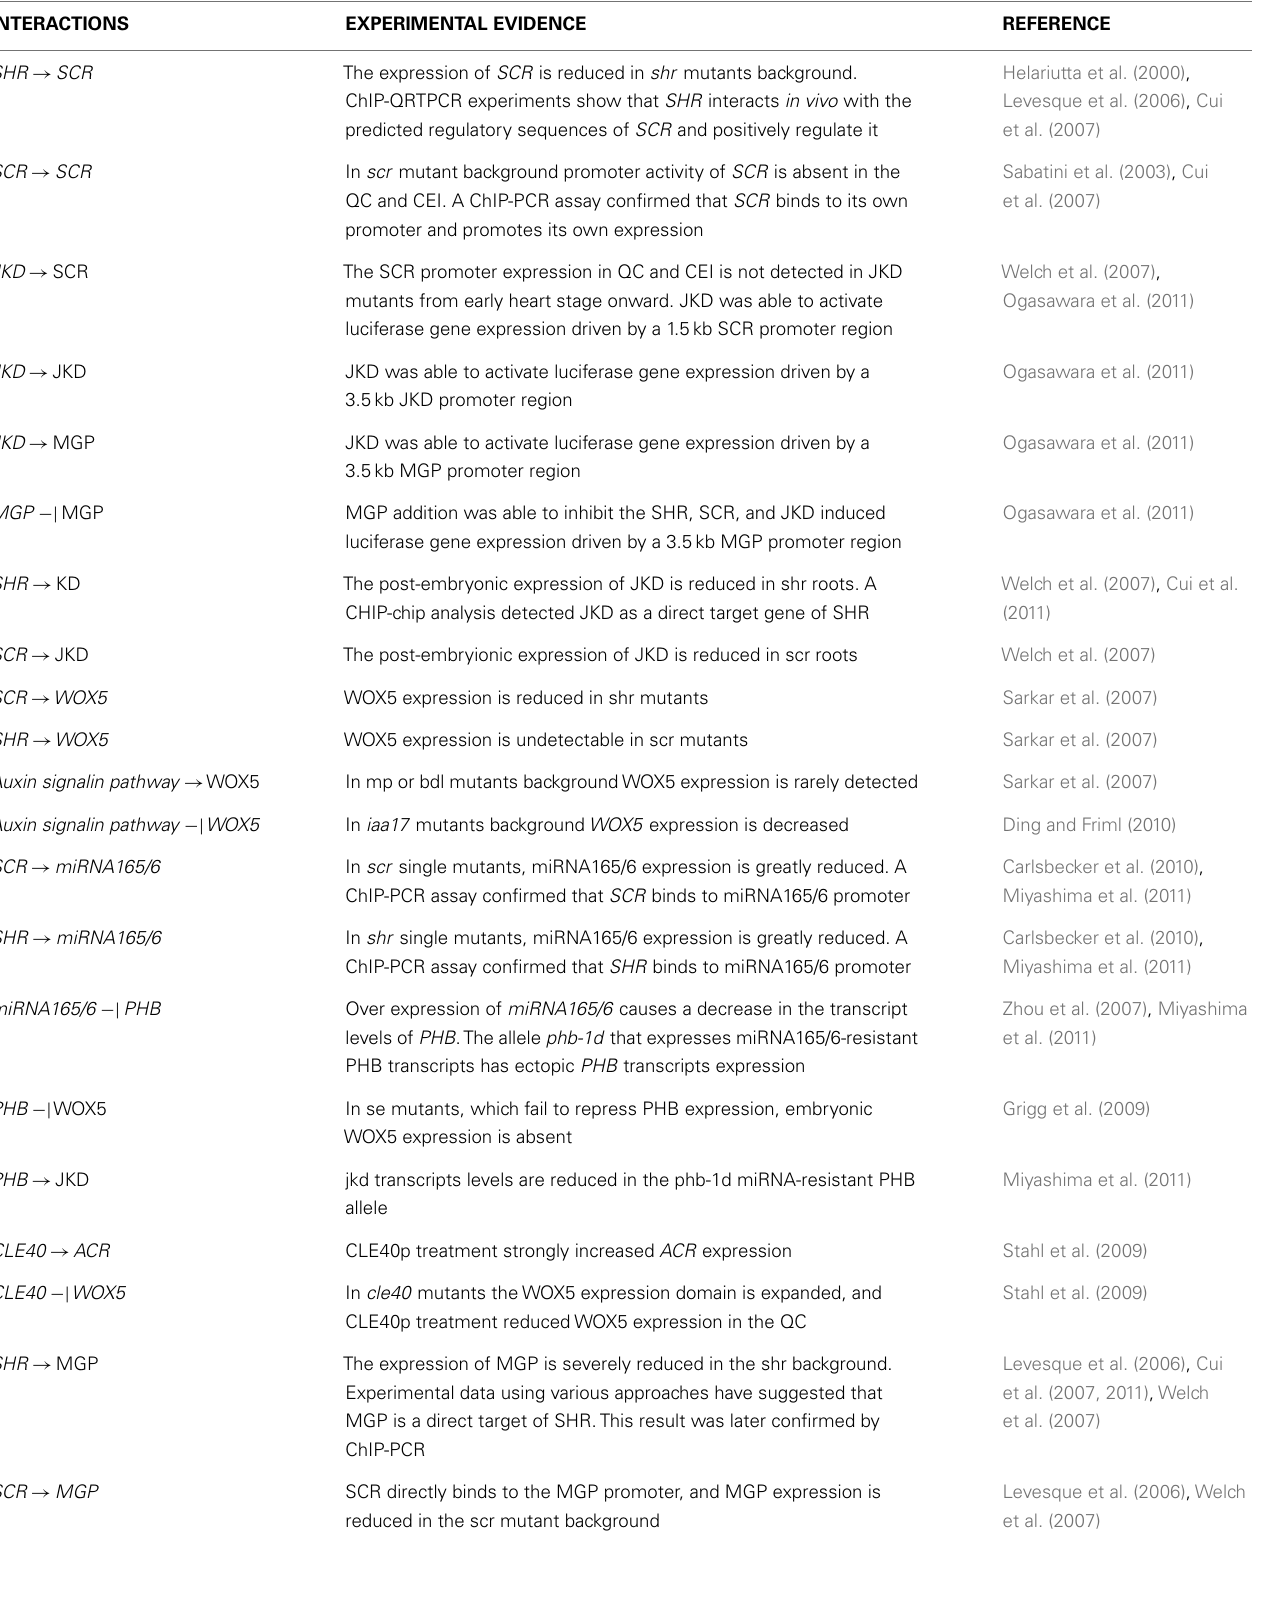
Table 1 | Main experimental information used in the RSCN